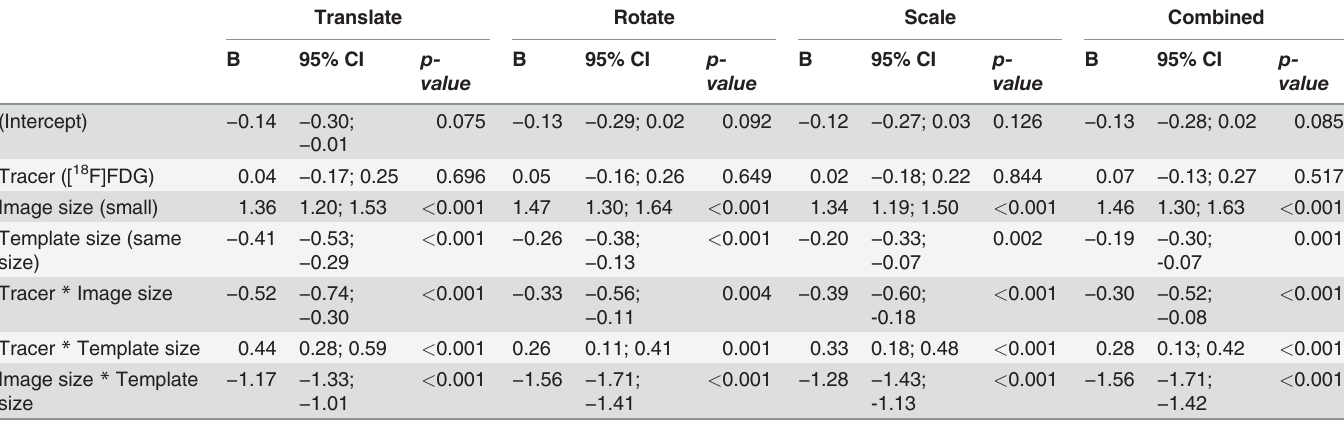
Table 6. Registration errors: effect of the template size. Translate Rotate Scale